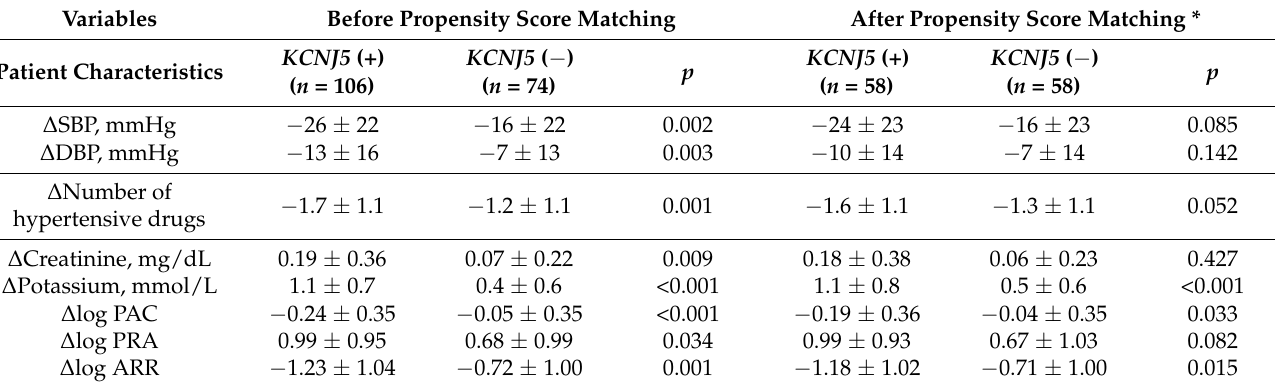
Table 2. Changes of clinical data of APA patients with and without KCNJ5 mutation after adrenalectomy before and after PSM. Variables Before Propensity Score Matching After Propensity Score Matching *